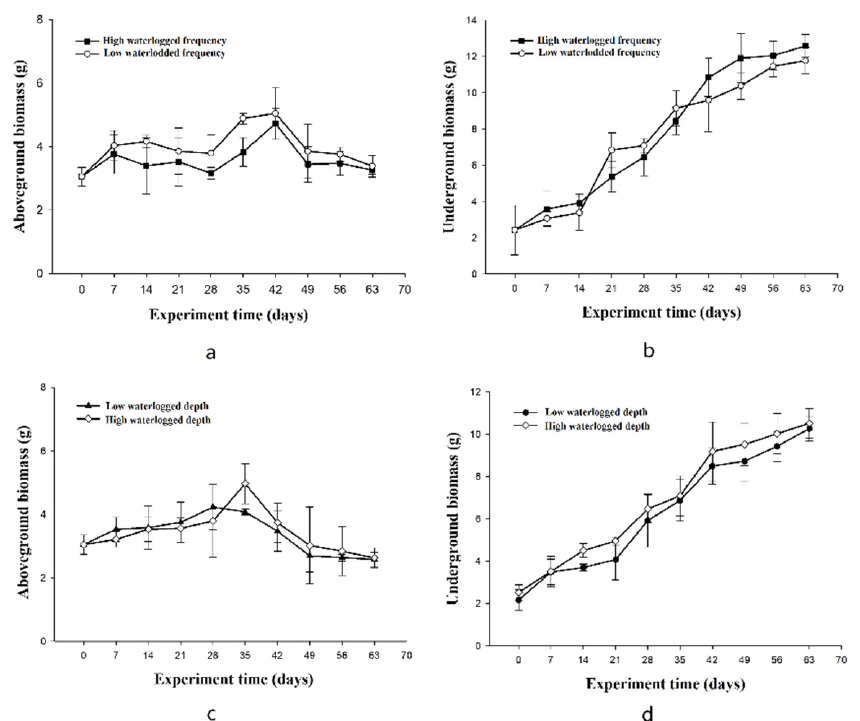
Figure 3. Dynamic changes in average biomass under different waterlogged conditions. ( a ) above- ground biomass of different waterlogged frequencies applied to the average of waterlogged depth option; ( b ) underground biomass of different waterlogged frequencies applied to the average of waterlogged depth option; ( c ) aboveground biomass of different waterlogged depths applied to the average of waterlogged frequencies option; ( d ) underground biomass of different waterlogged depths applied to the average of waterlogged frequencies